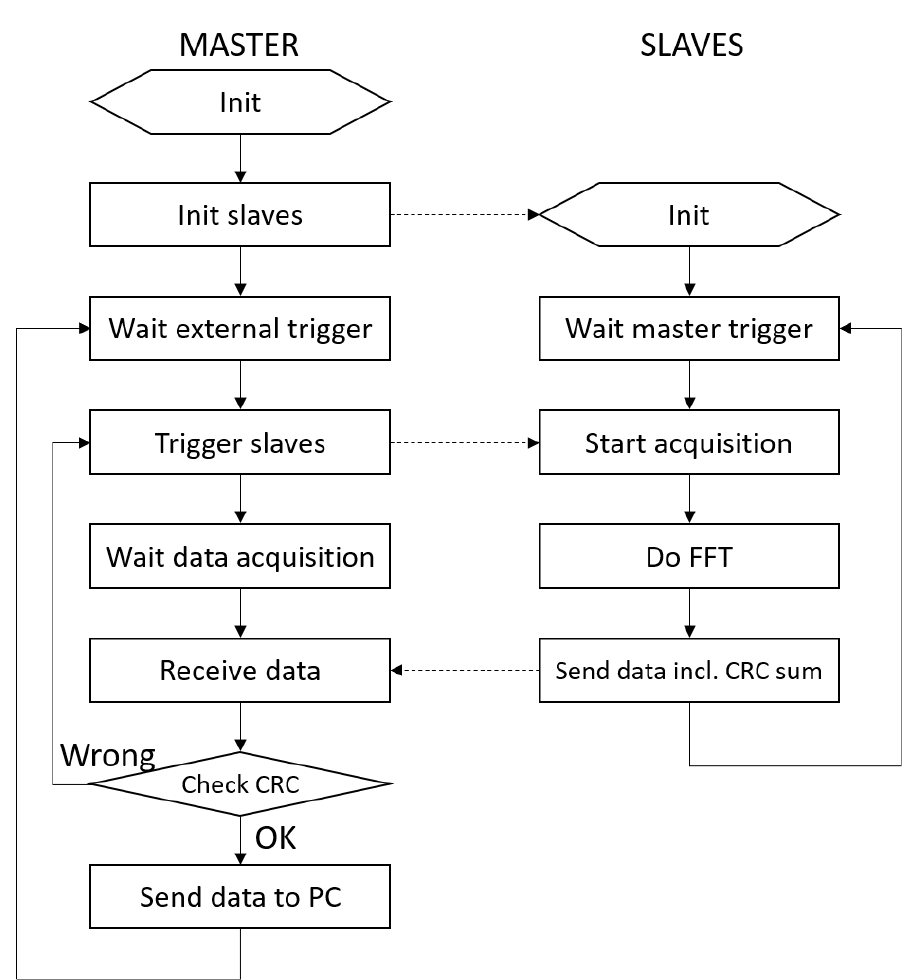
Figure 9. Simplified flow chart of master and slave